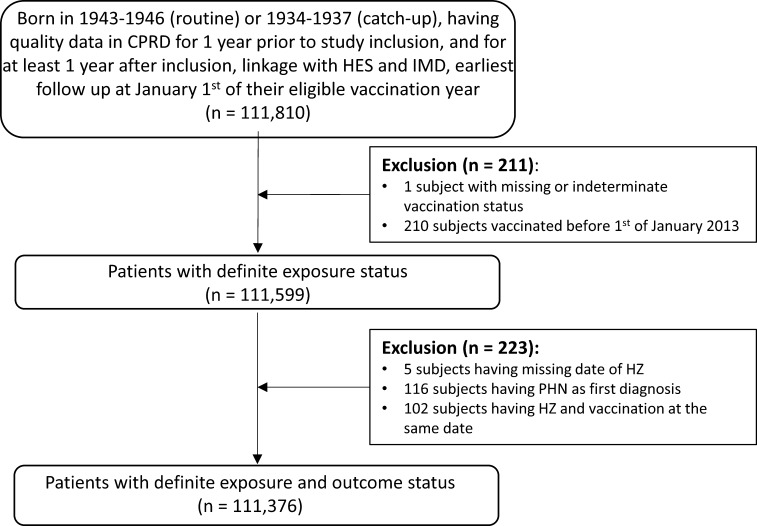
Attrition diagram.